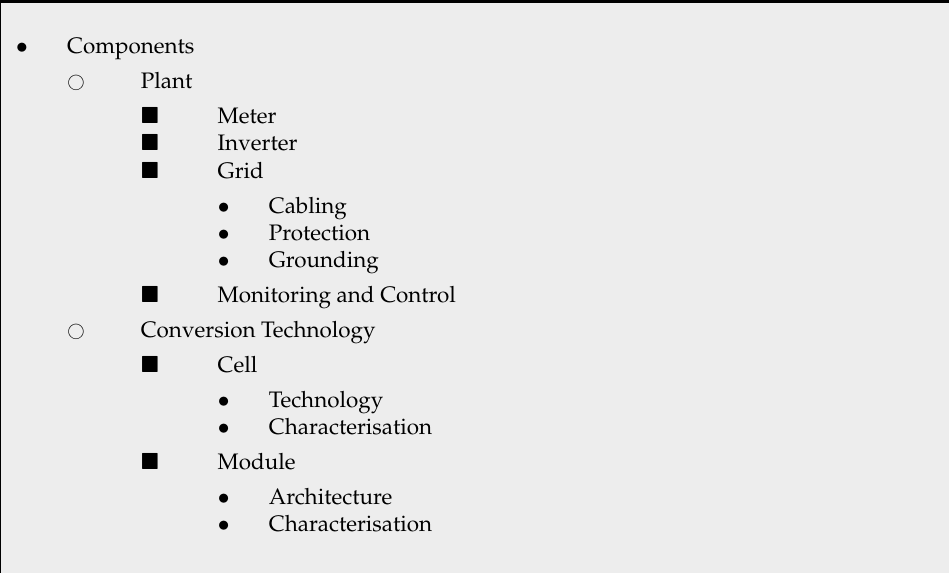
Table 5. Hierarchy for Component-related topics in the Production of Electricity from Solar